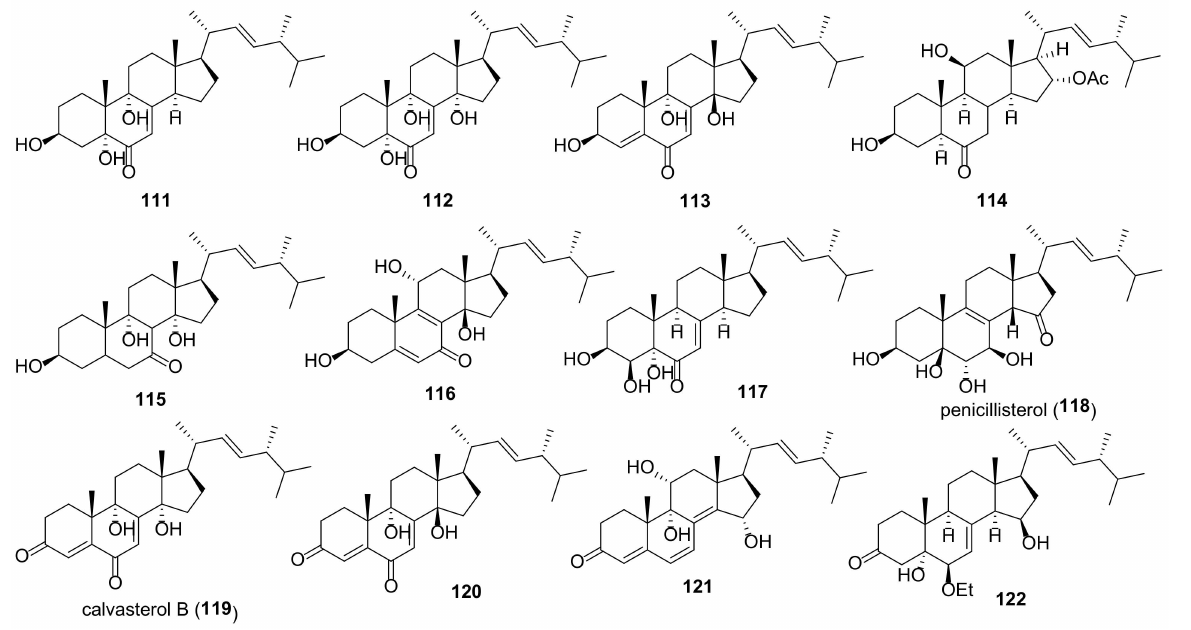
Figure 13. Structures of fungal hydroxyketones with four or more functional